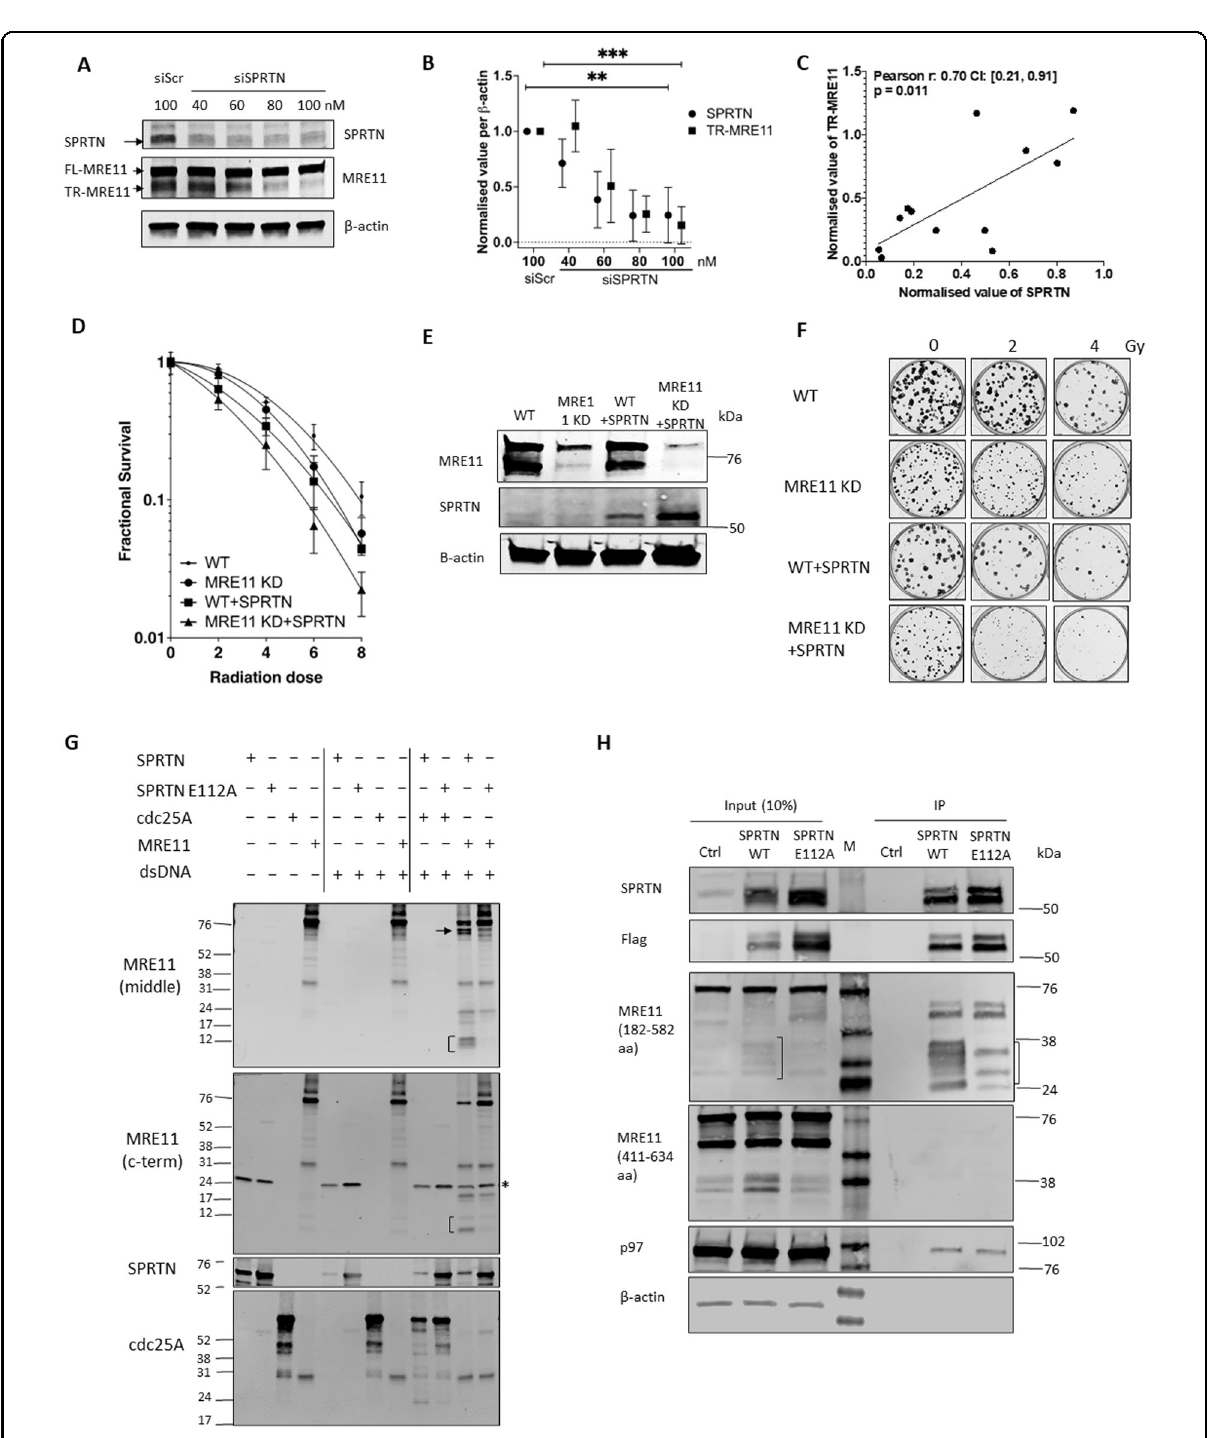
products that interact with SPRTN. Further studies would be required in order to investigate this possibility more